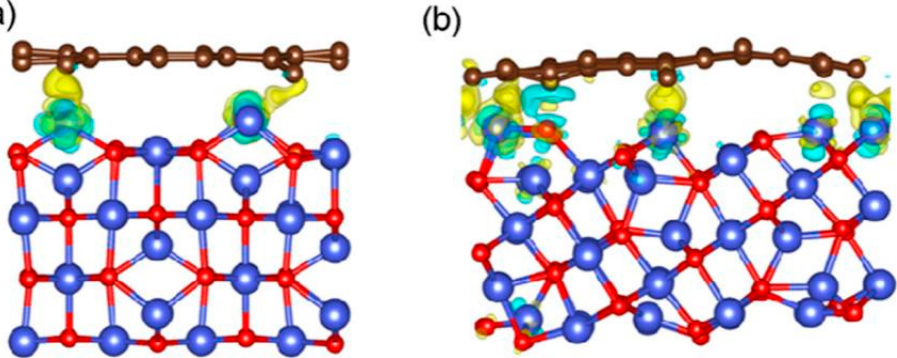
Figure 20. 3D electron density differences on the Co 3 O 4 (100)/graphene interface ( a ) and the Co 3 O 4 (112)/graphene interface ( b ). The cyan and yellow contours represent electron density depressions and accumulations, respectively [124].